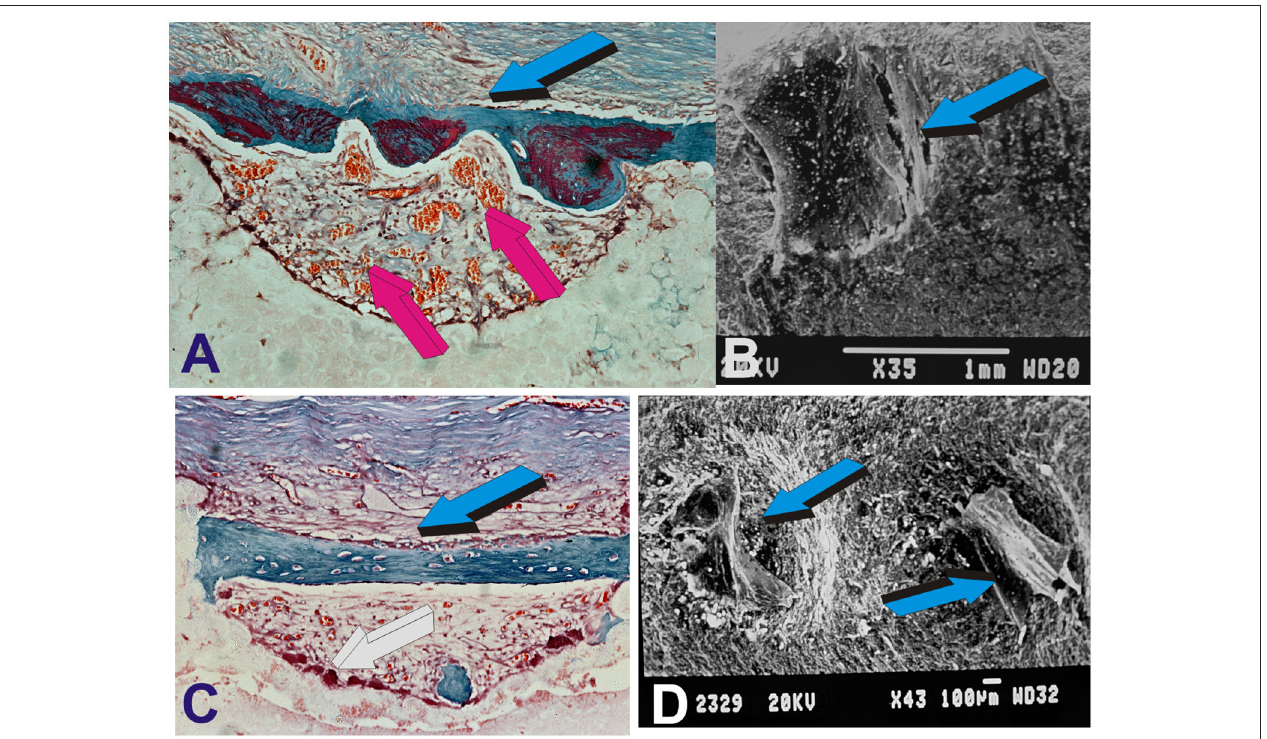
FIGURE 6 | The concavity, the shape of life, and the driving morphogenetic force of the geometric induction of bone formation. (A,C) Concavities, prepared in solid monolithic discs of sintered highly crystalline hydroxyapatite (Ripamonti et al., 1999, de novo generate intramembranous bone bridges (light blue arrows in A ) with pronounced vascular invasion and angiogenesis (magenta arrows). (B,D) 5 days after heterotopic implantation of titanium constructs as shown in Figure 4D , fibroblast-like cells synthesize collagen fibers across the edges of the concavities implanted in the rectus abdominis muscle of Papio ursinus . Fibroblast-like cells and/or myoendothelial cells synthesize collagen fibers migrating whilst synthesizing back and forward from the edges of the concavities (light blue arrows in B ) thus assembling extracellular matrix (C) for later mineralization and transformation into bone as shown in (A,C)